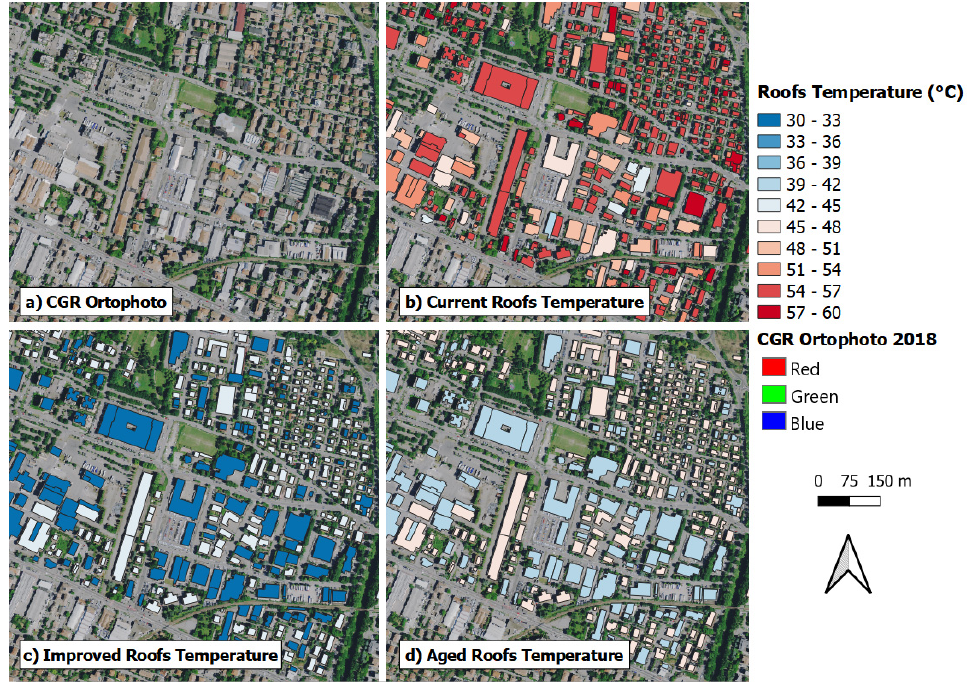
Figure 9. An example of building roof temperatures in the Carrozzone LCZ: ( a ) high resolution RGB image; ( b ) current surface temperature; ( c ) improved surface temperature after the application of solar reflective material; ( d ) aged scenario surface temperature.